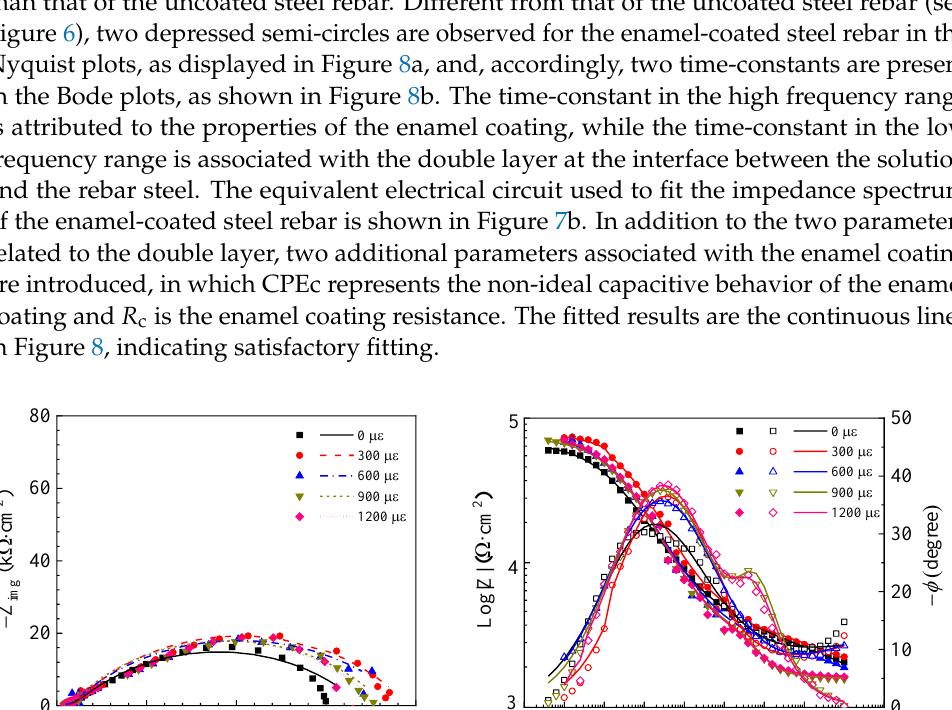
Figure 8. Impedance spectra of a representative enamel-coated steel rebar at different strain levels in the format of ( a ) Nyquist plots and ( b ) Bode plots.